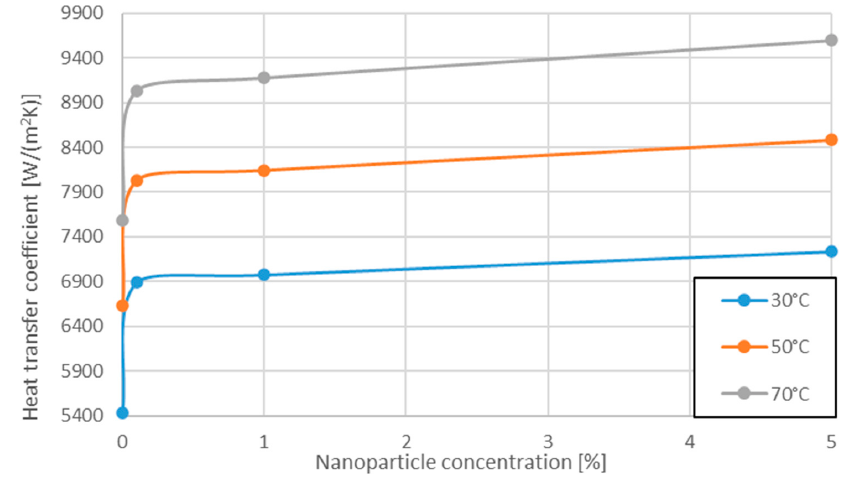
Figure 20. Variation of heat transfer coefficient for water-Al 2 O 3 nanofluids.